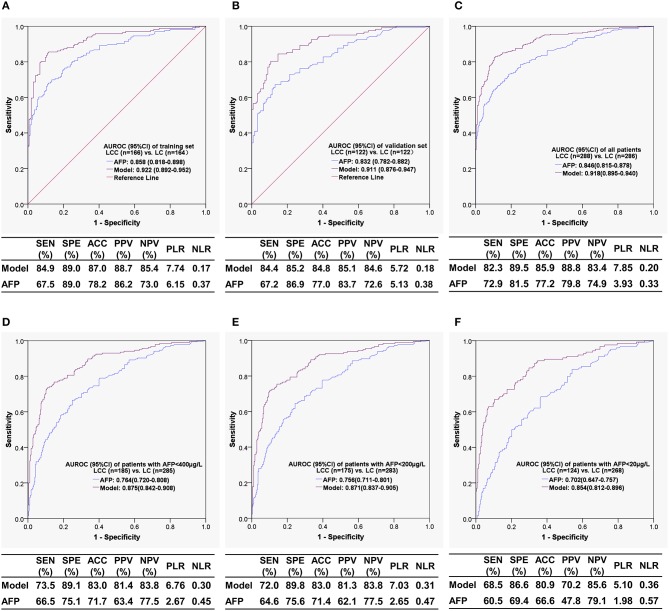
The receiver operating characteristic curves and diagnostic performances of the model for the diagnosis of liver cirrhosis complicated with hepatocellular carcinoma. (A) Training set; (B) validation set; (C) all patient set; (D) the set of patients with AFP < 400 μg/L; (E) the set of patients with AFP < 200 μg/L; (F) the set of patients with AFP < 20 μg/L. AUROC, area under the receiver operating characteristic curve; CI, confidence interval; LCC, liver cirrhosis complicated with hepatocellular carcinoma; LC, liver cirrhosis; AFP, alpha-fetoprotein; SEN, sensitivity; SPE, specificity; ACC, accuracy; PPV, positive predictive value; NPV, negative predictive value; PLR, positive likelihood ratio; NLR, negative likelihood ratio.